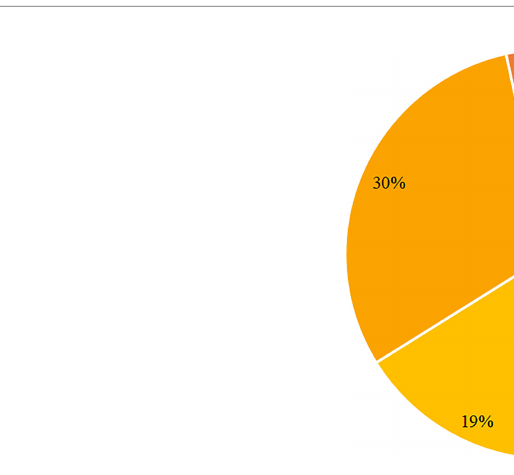
FIGURE 5 | Proportion of OTUs at each identity level in total OTUs in the SCS